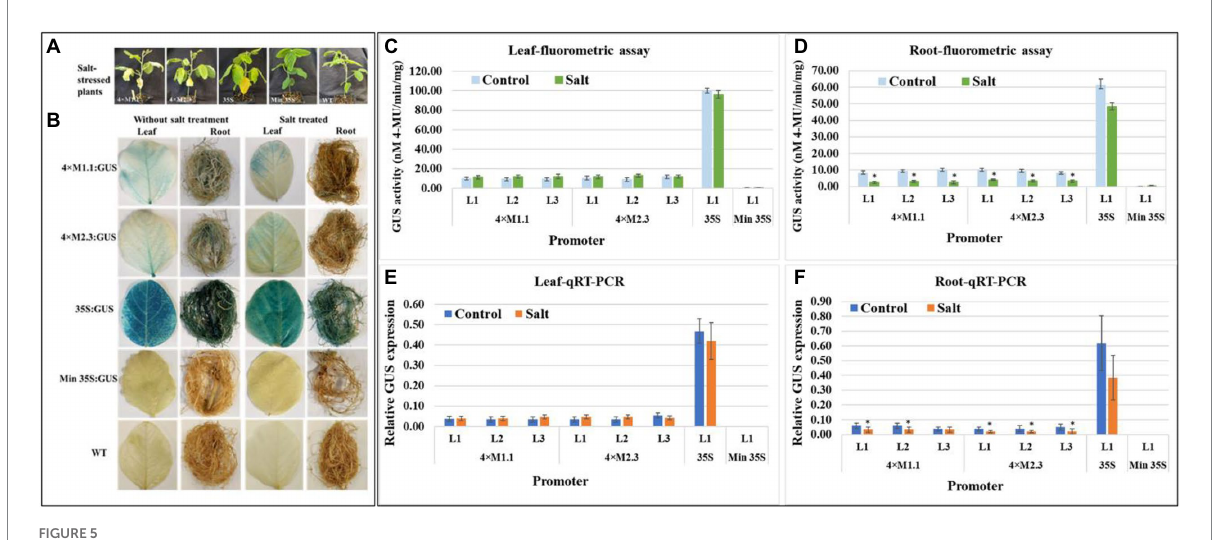
FIGURE 5 GUS activity in leaves and roots of 3-week-old T 3 transgenic soybean containing the individual promoter-GUS construct subjected to mock (untreated control) and salt treatment. (A) Representative plants were irrigated with 250 mM NaCl solution for 7 days. (B) Histochemical staining for GUS activity in transgenic soybean and wild-type (WT) plants. (C,D) Fluorometric assay for GUS activity in leaf (C) and root (D) . (E,F) Quantitative real-time RT-PCR (qRT-PCR) analysis for GUS expression in leaf (E) and root (F) . The relative levels of transcripts in qRT-PCR were normalized to